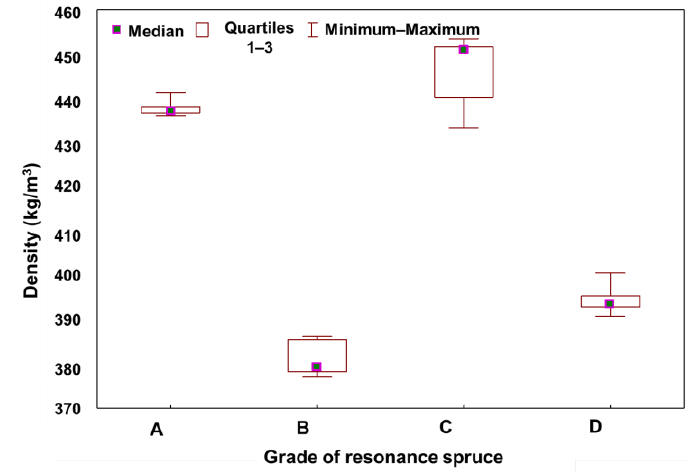
Figure 5. The stratification of the density of spruce wood according to the specimen grade.